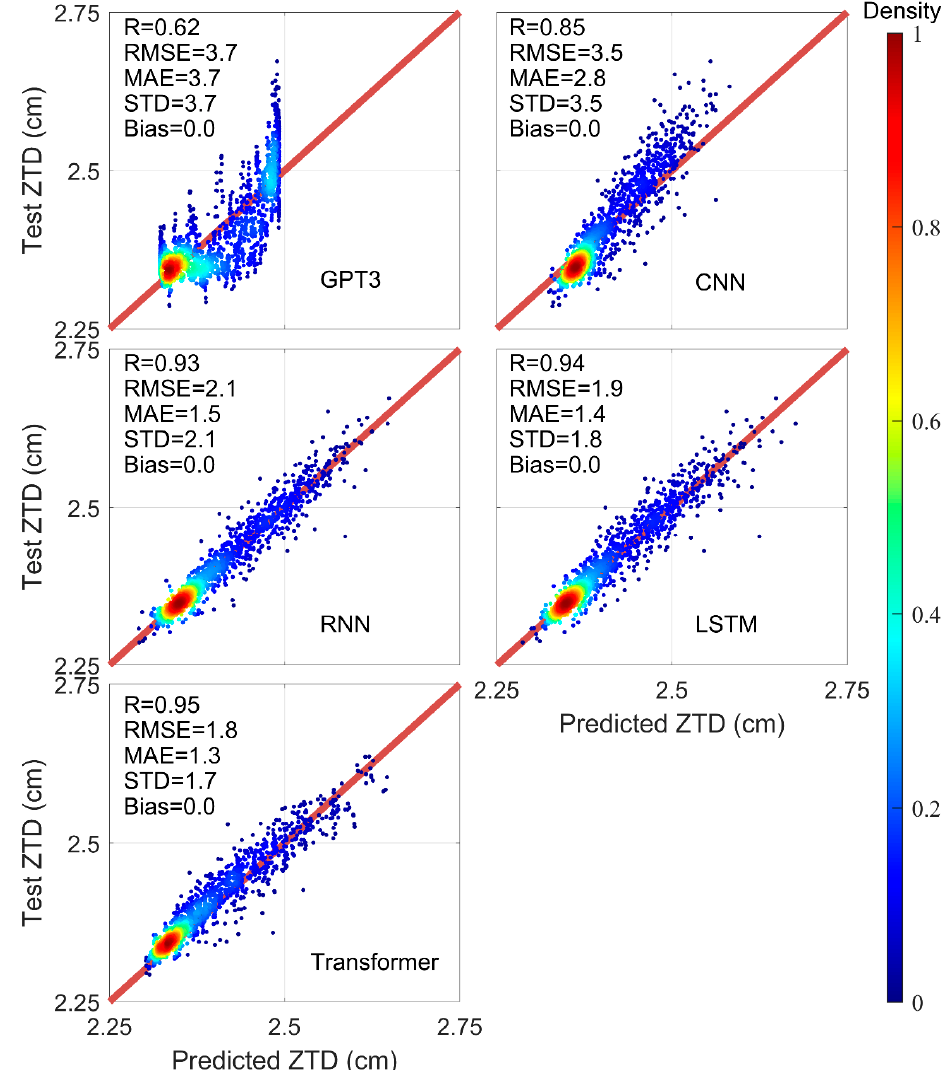
Figure 10. Comparison of the forecasting accuracy of the different models.